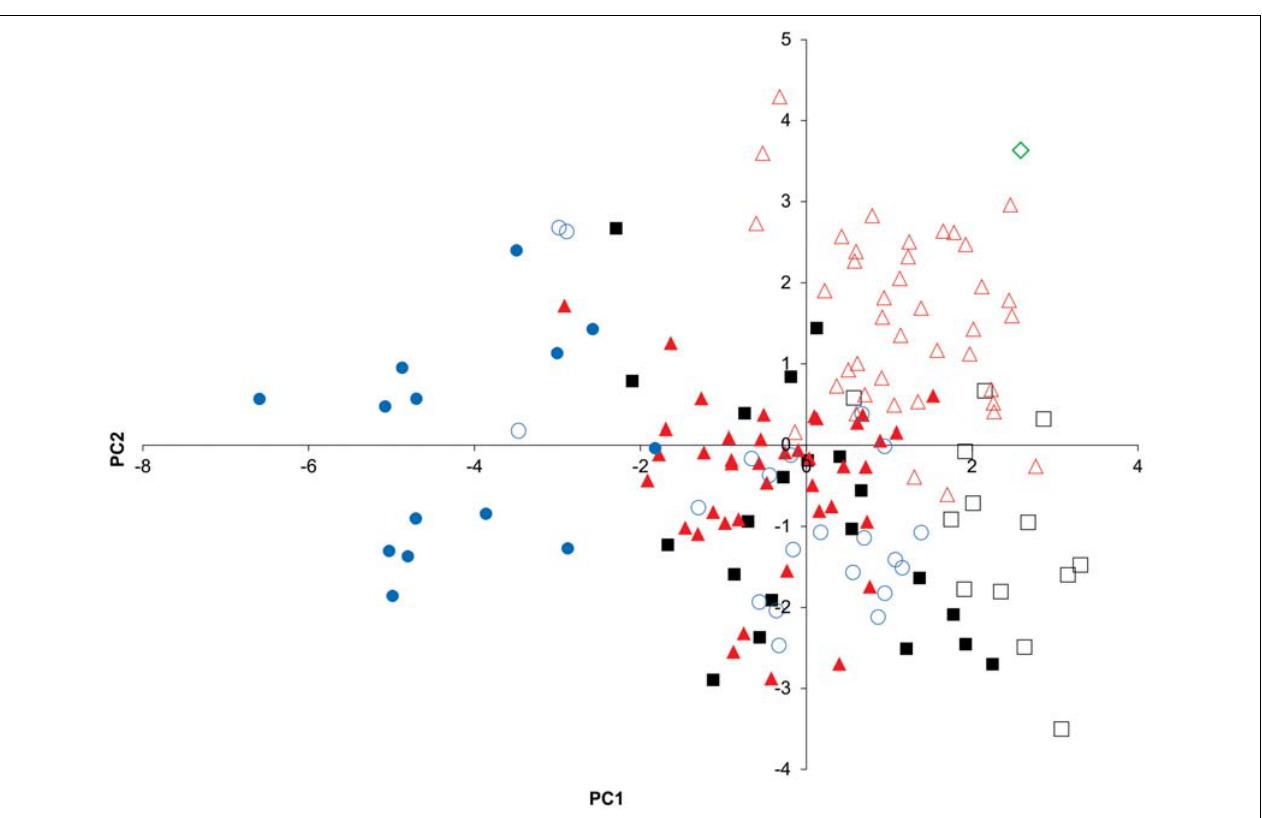
FIGURE 3 | Principal component (PC) analysis (PC1 vs. PC2) based on linear morphometric measurements of body. The 1st 2 PCs explained 55.6% of the variance in the data. Psammobatis rudis males (black squares); P. rudis females (white squares); P. normani males (red triangles); P. normani females (white triangles ); P. lentiginosa males (blue circles); and P. lentiginosa females (white circles). Holotype of P. parvacauda (white